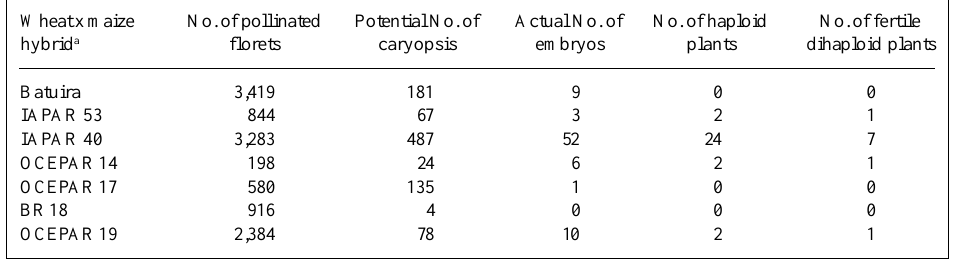
Table IV - Number of embryos, haploid and dihaploid somaclonal plants of some wheat cultivars regenerated through embryo rescue technique.